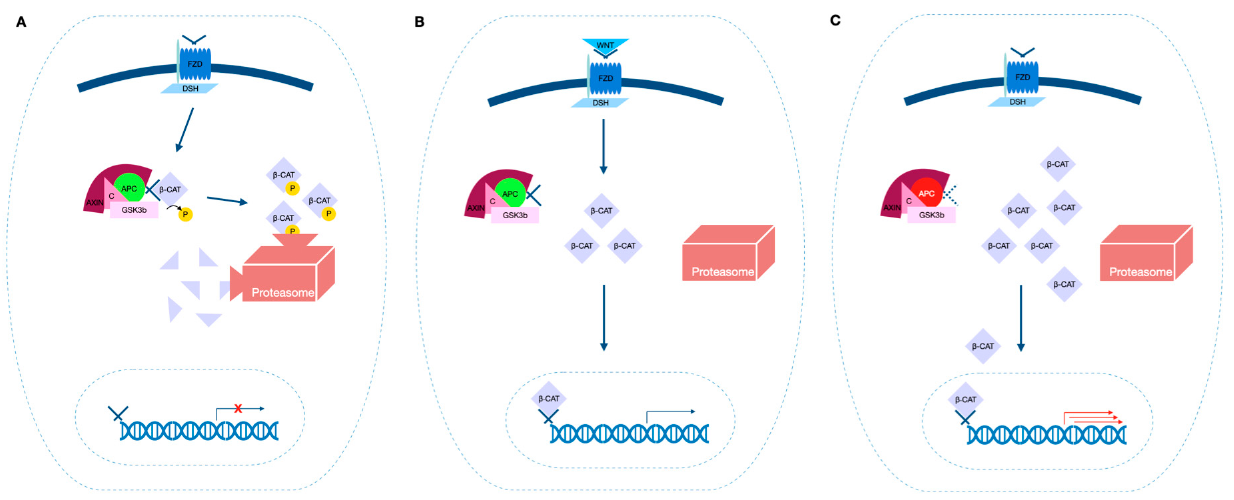
Figure 1. The simplified WNT/ β -catenin pathway. ( A ) The WNT/ β -catenin pathway in the absence of APC mutation (green) and without the ligand WNT: the “destruction complex” bounds, phosphorylates and targets β -catenin for ubiquitination; β -catenin is then degraded by proteasomes. ( B ) The WNT/ β -catenin pathway in the absence of APC mutation (green) and with the presence of the ligand WNT: after WNT binds its receptor frizzled activating further intracellular molecules, β - catenin is no longer captured by the “destruction complex”; it accumulates in the cytoplasm and it migrates to the nucleus, where it acts as a transcription factor. ( C ) When APC is mutated (red), a faulty “destruction complex” is unable to bind and ubiquitinate β -catenin; as a result, it acts as an uncontrolled mitogenic signal, even in the absence of activation of the WNT signaling pathway by the ligand WNT. APC: adenomatous polyposis coli; C: conductin; GSK3b: glycogen synthase kinase 3 b; β -CAT: β -catenin; FZD: Frizzled receptor; DSH: Disheveled; P: phosphorylation.